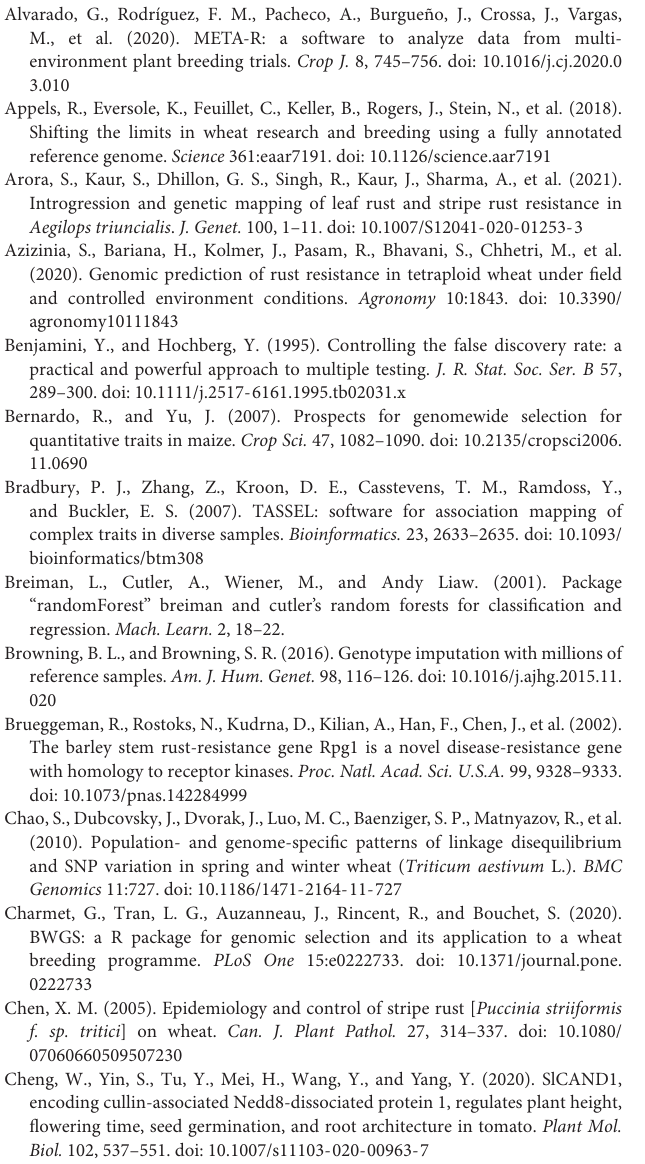
Supplementary Table 1 | List of 141 Genotypes with pedigree information used in present study. Supplementary Table 2 | SNP Hapmap file used in present study. Supplementary Table 3 | Phenotypic data used in present study.